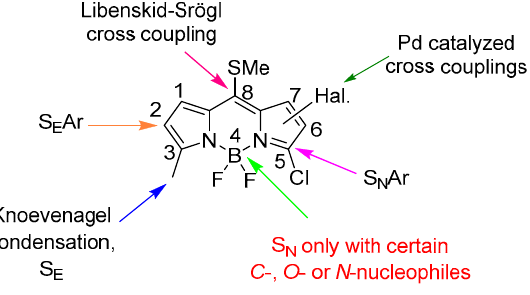
Figure 1. Some useful chemical transformations in BODIPY dyes. In red, functionalization at the boron atom reported to